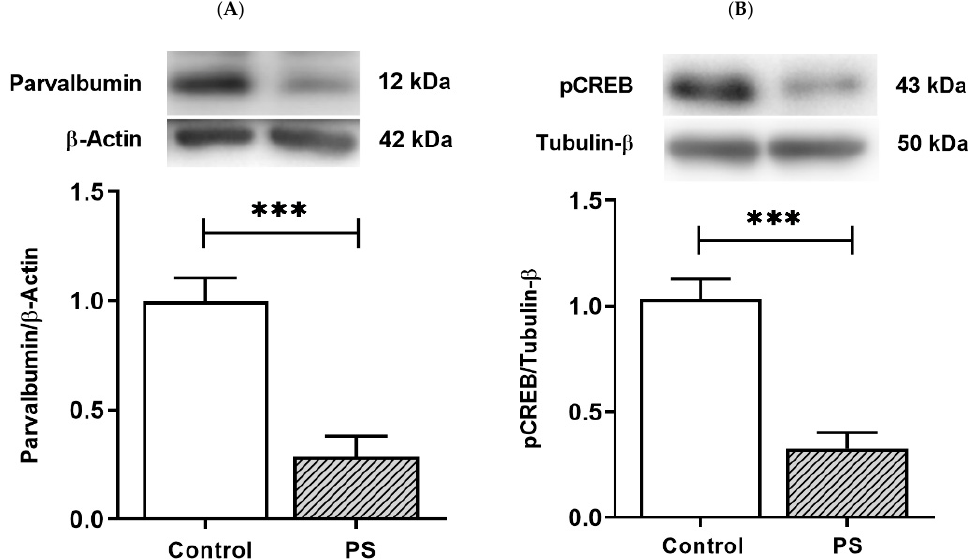
Figure 4. The plasticity regulation of GABAergic interneurons. ( A ) Western blotting of PV. Upper, band comparing the control (left) and prenatal stress (PS) (right) groups; lower, bar graph displays the analysis of protein band densities of the PV/ β –actin ratio; the significant differences at *** p < 0.001. ( B ) Western blotting of pCREB. Upper, band comparing the control (left) and PS (right) groups; lower, bar graph displays the analysis of protein band densities of the pCREB/Tubulin- β ratio; the significant differences at *** p < 0.001. Data are shown as Mean ± SEM, n = 5.